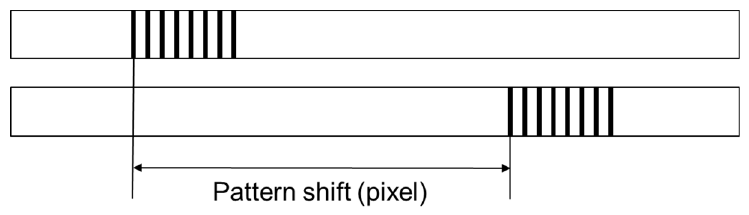
Figure 2. Schematic of pattern shift between two images.